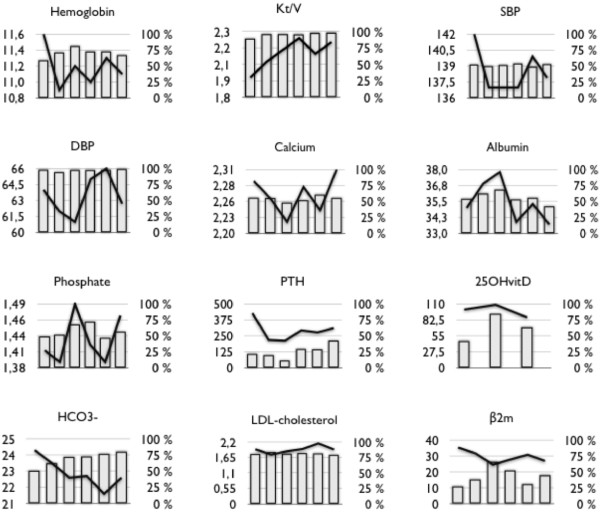
Quality indicators: Evolution of mean levels (lines) and conformity rates (histograms) during the 6 quarters. Hemoglobin (g/dl) ; SBP and DBP : Systolic and Diastolic Blood Pressure (mmHg) ; Serum Calcium (mmol/l) ; Serum Albumin (g/l) ; Serum Phosphate (mmol/l) ; PTH (pg/ml) ; 25OHvitaminD (nmol/l) ; Serum Bicarbonate (mmol/l) ; LDL-cholesterol (mmol/l) ; β2-microglobulin (mg/l).